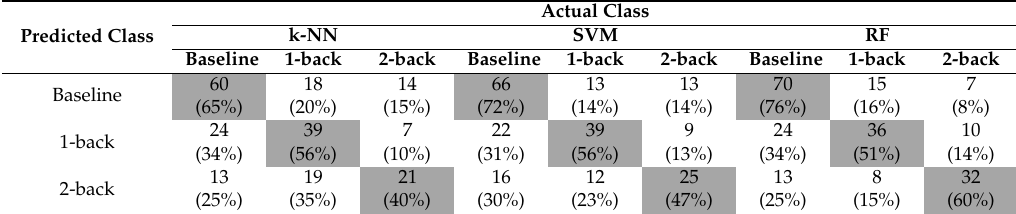
Table 3. Confusion matrix of k-nearest neighbour (k-NN), support vector machine (SVM), and random forest (RF) multiclass classification on the test dataset. The grey cells represent the true positive (TP) value. TP represents the number of observations that were correctly classified, and the precision value in percentage.